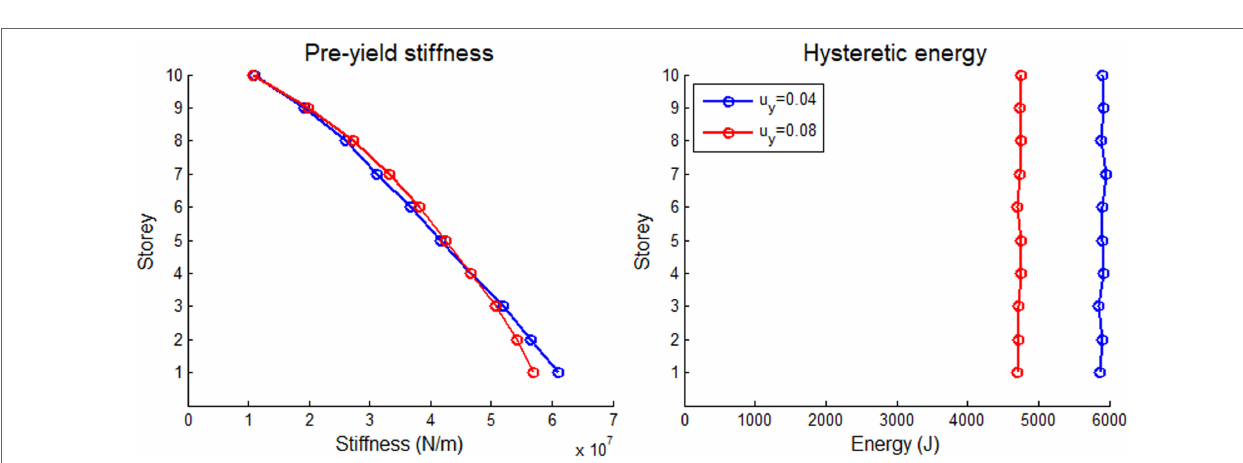
FIGURE 13 | Optimum distributions of elastic pre-yield stiffness and energy dissipated due to hysteresis for the 10-storey shear building with ξ = 5% subject to the El Centro earthquake record for various normalized yield inter-storey drifts.